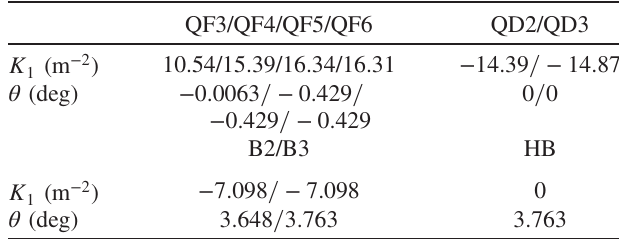
TABLE X. Magnet parameters for the three sectors with hard bends (HB). Only the magnets with settings different from those in the normal sectors are reported.